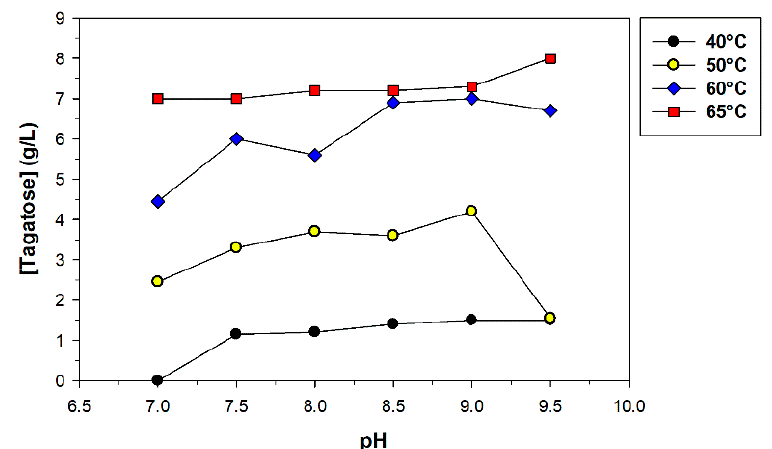
Figure 5. E ff ect of temperature and pH on the production of D-tagatose by L-arabinose isomerase Figure 5. Effect of temperature and pH on the production of D -tagatose by L -arabinose isomerase US100 from B. stearothermophilus . Experimental conditions: 20 g / L D-galactose in bu ff er 100 mM MOPS US100 from B. stearothermophilus . Experimental conditions: 20 g/L D -galactose in buffer 100 mM MOPS containing 0.5 mM MnSO 4 , 0.65 U / mL L-AI. The concentration of D-tagatose was measured after 4 h containing 0.5 mM MnSO 4 , 0.65 U/mL L-AI. The concentration of D -tagatose was measured after 4 h by by HPAEC-PAD.